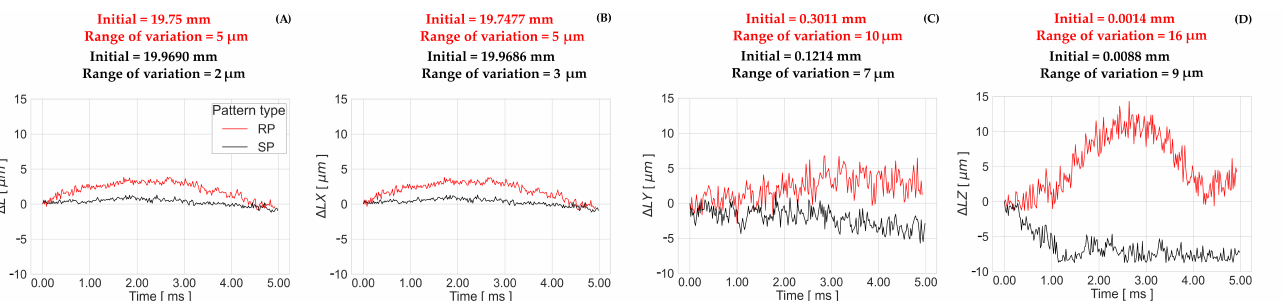
Figure 19. Length variation ( A ) ∆ L , ( B ) ∆ LX , ( C ) ∆ LY , and ( D ) ∆ LZ for the best-performing patterns (RP 06 and SP 02) under static conditions using the raw data and a mean filter of 5 neighbors on the time axis.